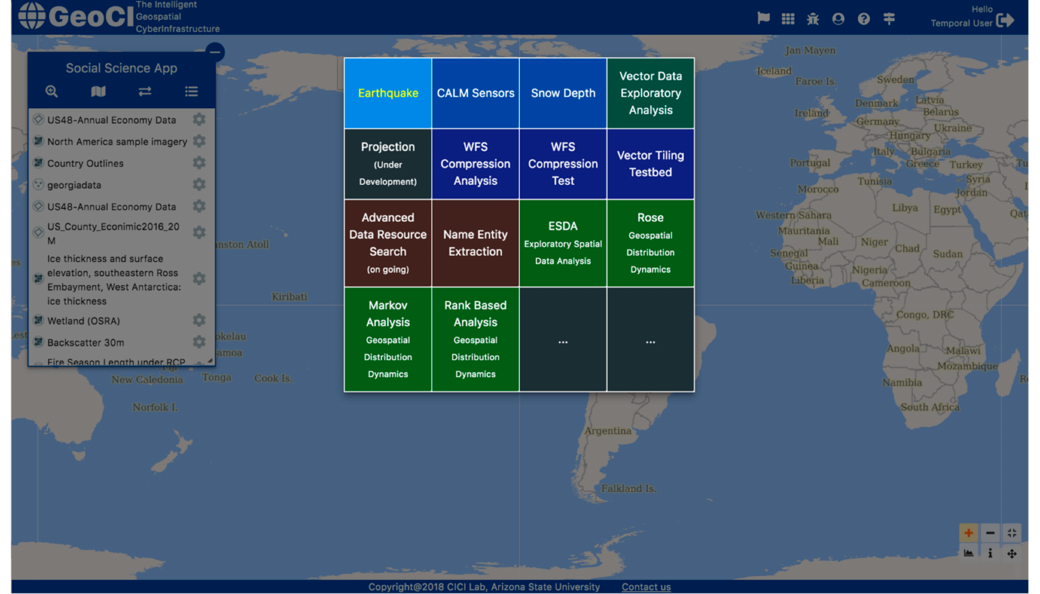
Figure 12. Use cases enabled in the cyberinfrastructure portal